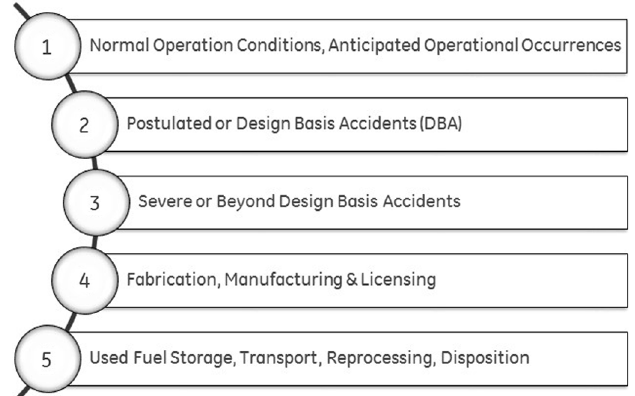
Fig. 2. Five metric Areas Provided by DOE to Evaluate